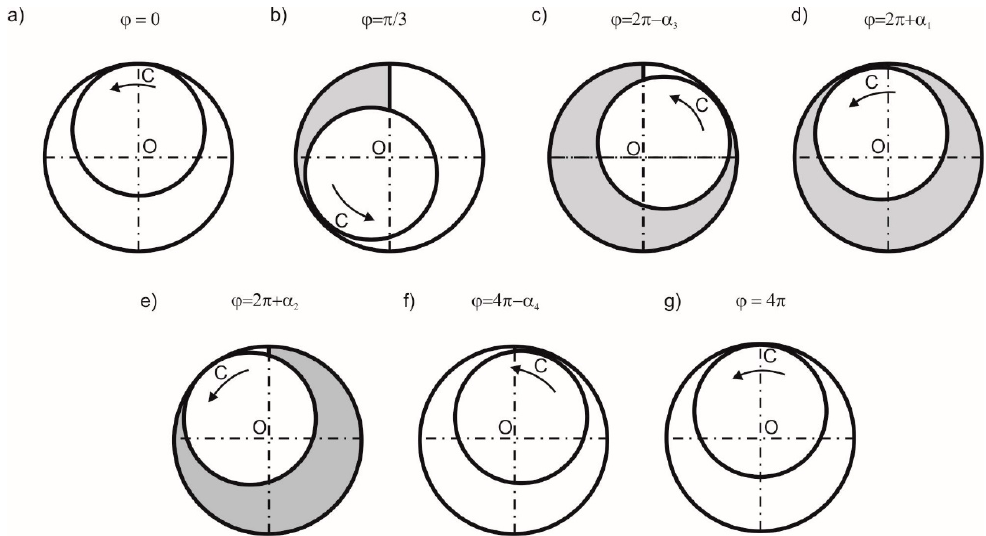
Figure 3. The process of gas expansion in the rolling piston expander. ( a ) Beginning of the working cycle; ( b ) end of the working chamber filling; ( c ) end of expansion; ( d ) the moment of the inlet valve re-opening; ( e ) the moment of the outlet valve opening (beginning of the evacuation); ( f ) end of the evacuation; ( g ) end of the working cycle.